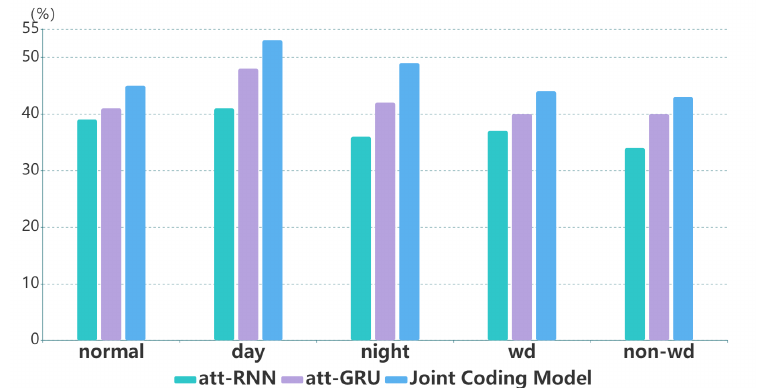
Figure 4. The Recall@20 of different groups in experiment